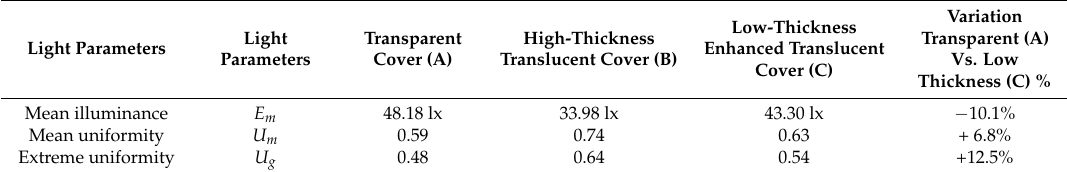
Table 9. Comparative summary of the lighting results in an urban roadway: mean illuminance ( E m ) and uniformities ( U m and U g